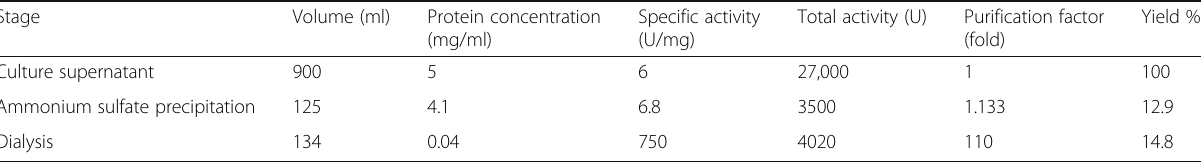
Table 1 Summary of the purification procedure of killer toxin from Torulaspora delbrueckii Stage